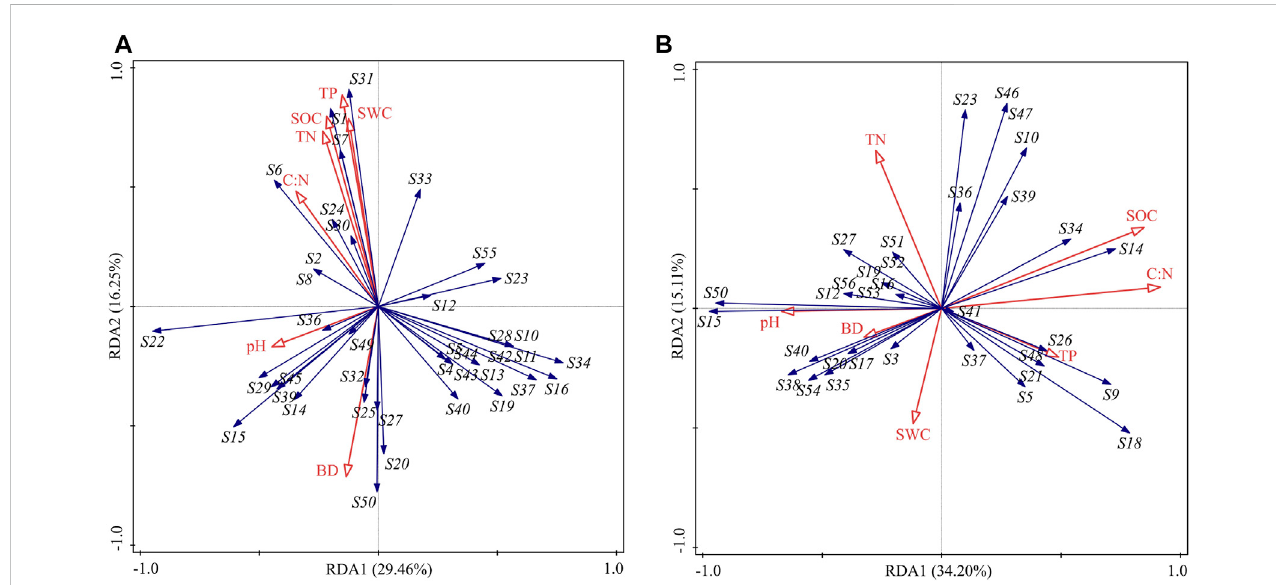
FIGURE 6 RDA ordination plots of the vegetation composition in the silt-amended peatland (A) and sand-amended peatland (B) constrained by environmental factors. SOC, soil organic carbon; SWC, soil water content; BD, bulk density; TN, total nitrogen; TP, total phosphorus; C:N, carbon to nitrogen ratio. Note: